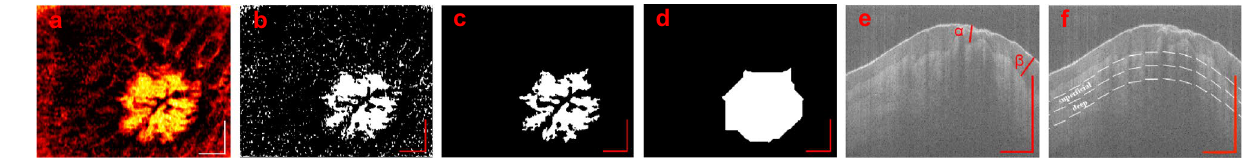
Figure 1. Image analysis pipeline for lesion quantification. ( a ) Enface image generated by DSDLI, ( b ) filtered and binarized image, ( c ) isolated lesion vasculature, ( d ) dilated and closed image, ( e ) structural slice image,